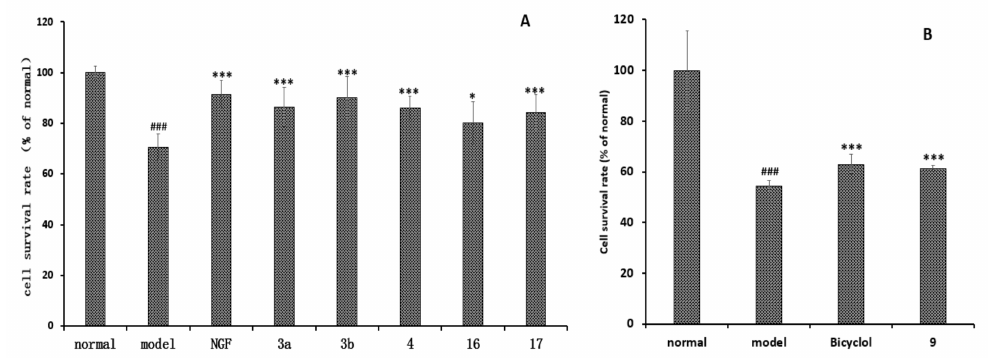
Figure 8. The neuroprotective and hepatoprotective effects of compounds isolated from C. lansium . ( A ) Neuroprotective effects of compounds 3a , 3b , 4 , 16 , 17 against okadaic acid-induced injury in PC12 Cells (10 µ M, means ± SD, n = 6); ( B ) Hepatoprotective effects of compounds 1 – 4 and 6 – 17 (10 µ M) against N -acetyl- p -aminophenol (APAP)-induced toxicity in HepG2 (human hepatocellular liver carcinoma cell line) cells (10 µ M, means ± SD, n = 6). ( ### p < 0.001 vs. normal, *** p < 0.001, * p < 0.1 vs.